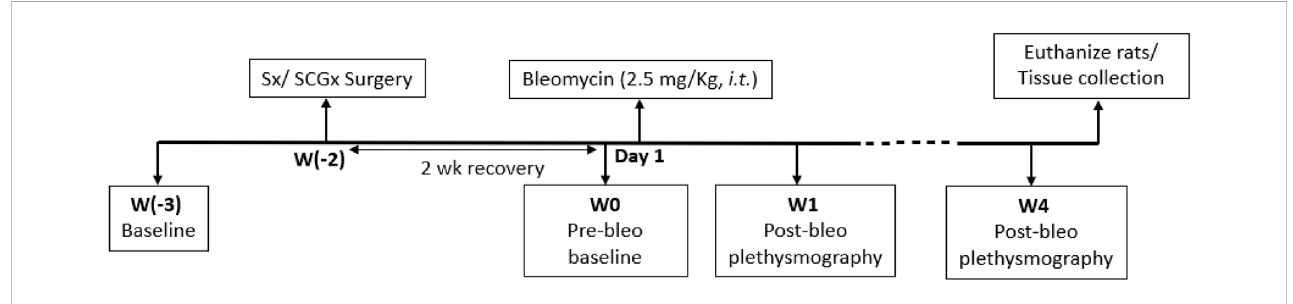
FIGURE 1 Timeline showing experimental